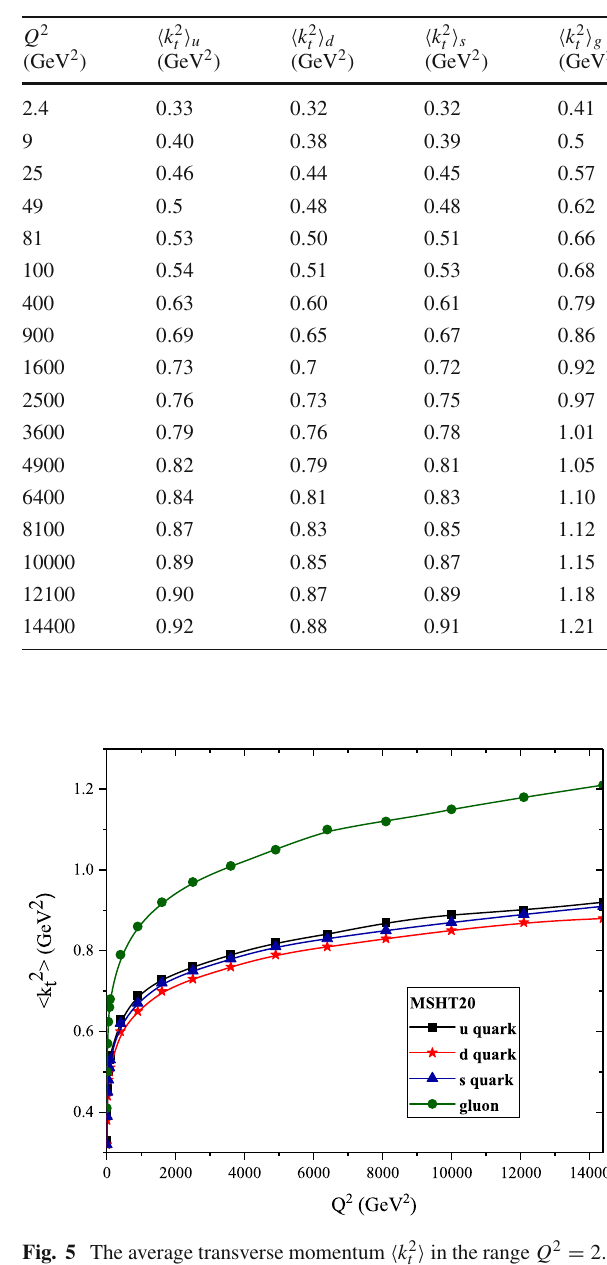
Fig. 5 The average transverse momentum (cid:2) k 2 t (cid:3) in the range Q 2 = 2 . 4 to 1 . 44 × 10 4 GeV